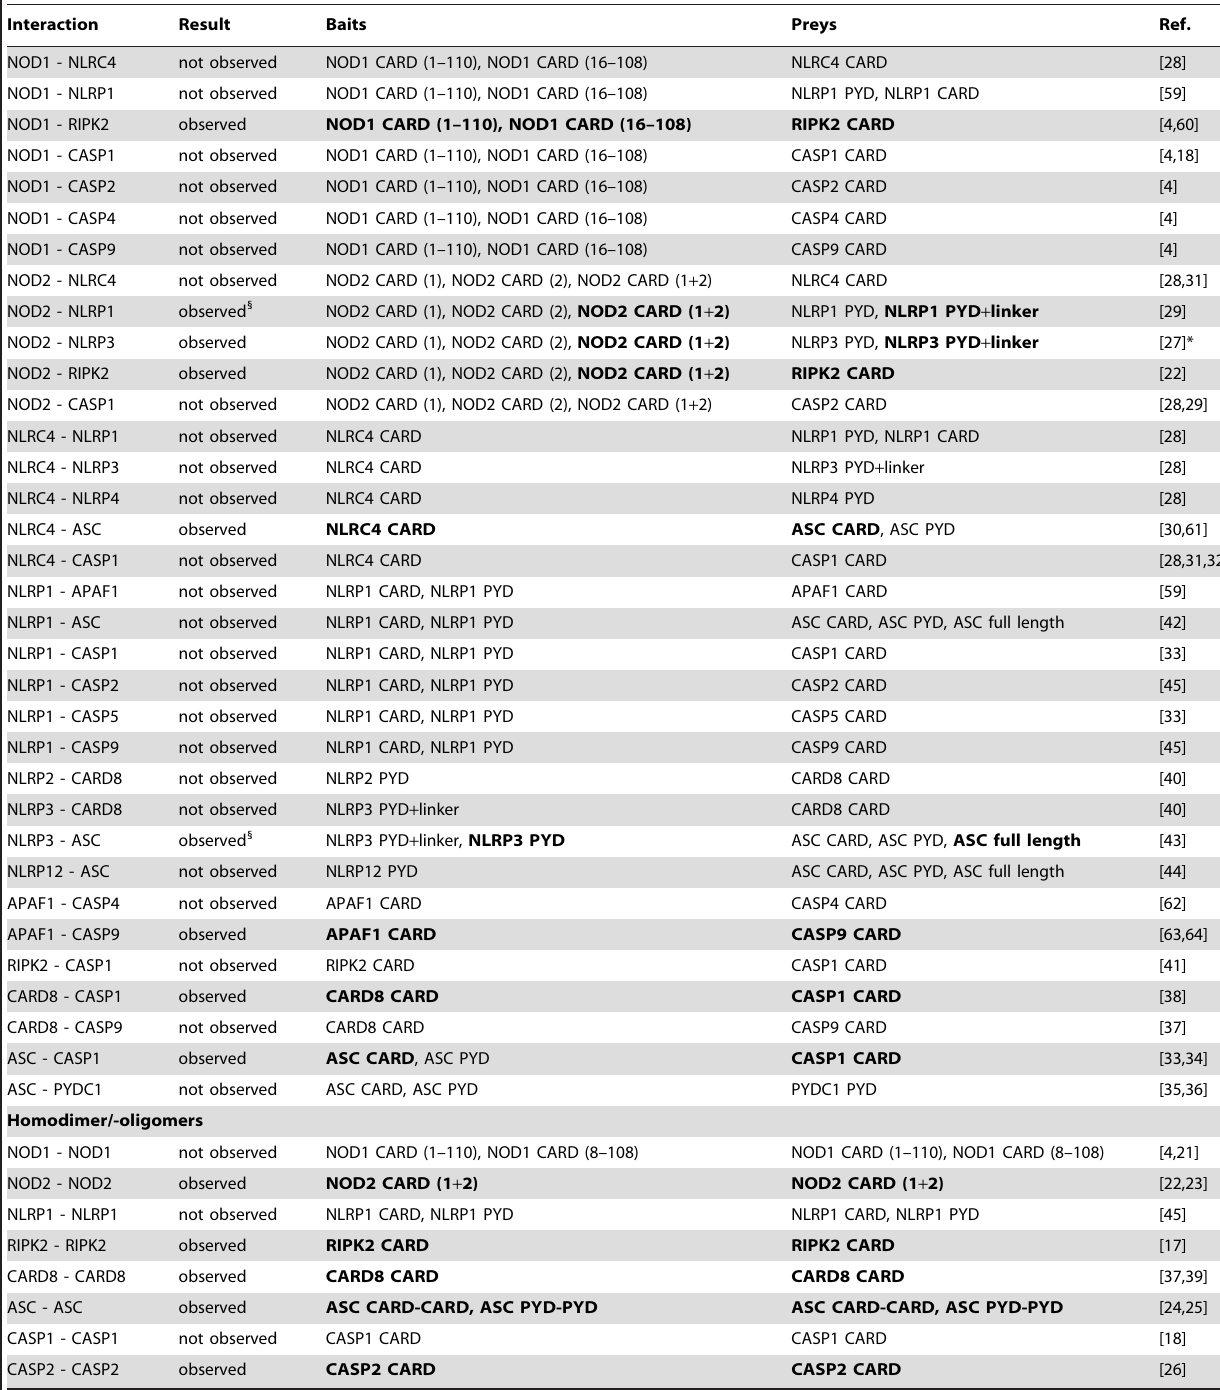
Respective protein-protein interactions were mined from the scientific literature or retrieved from MiMI [65]. Results represent data from our yeast two-hybrid analysis (interaction observed or not observed). Baits and preys indicate individual domains tested in our analysis with interacting constructs in bold. References to reported interactions are specified. 1 Initially not observed by ‘‘each against all’’ approach, but observed subsequently with refined constructs. * No data on a direct